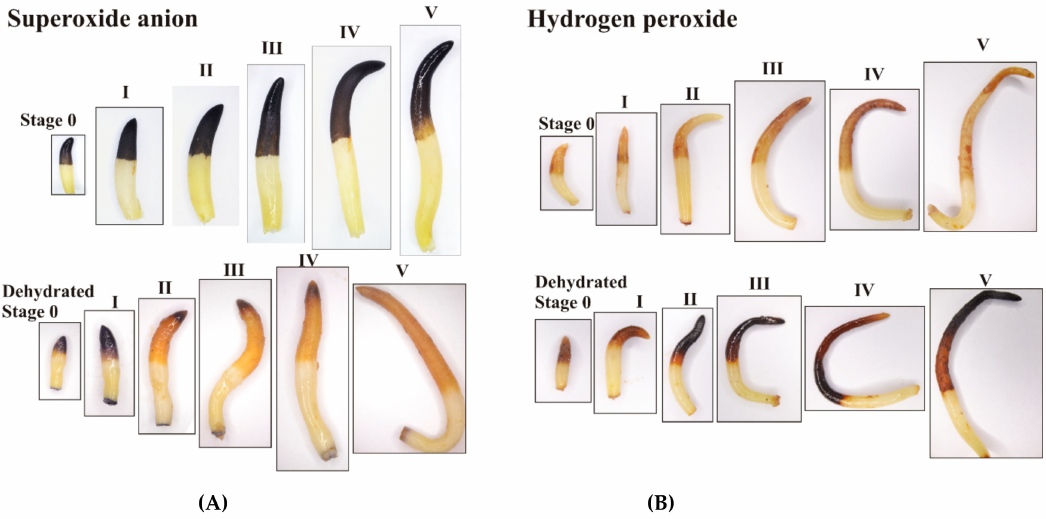
Figure 6. Histochemical detection of ( A ) superoxide anion radical (O 2 •− ) and ( B ) hydrogen peroxide (H 2 O 2 ) in beech elongating embryonic axes at early seedling establishment 0-V stages before and after dehydration. H 2 O 2 was visualized as reddish-brown stain, whereas O 2 •− was visualized as a black stain. A representative image of the elongating embryonic axis from each seedling establishment stage is